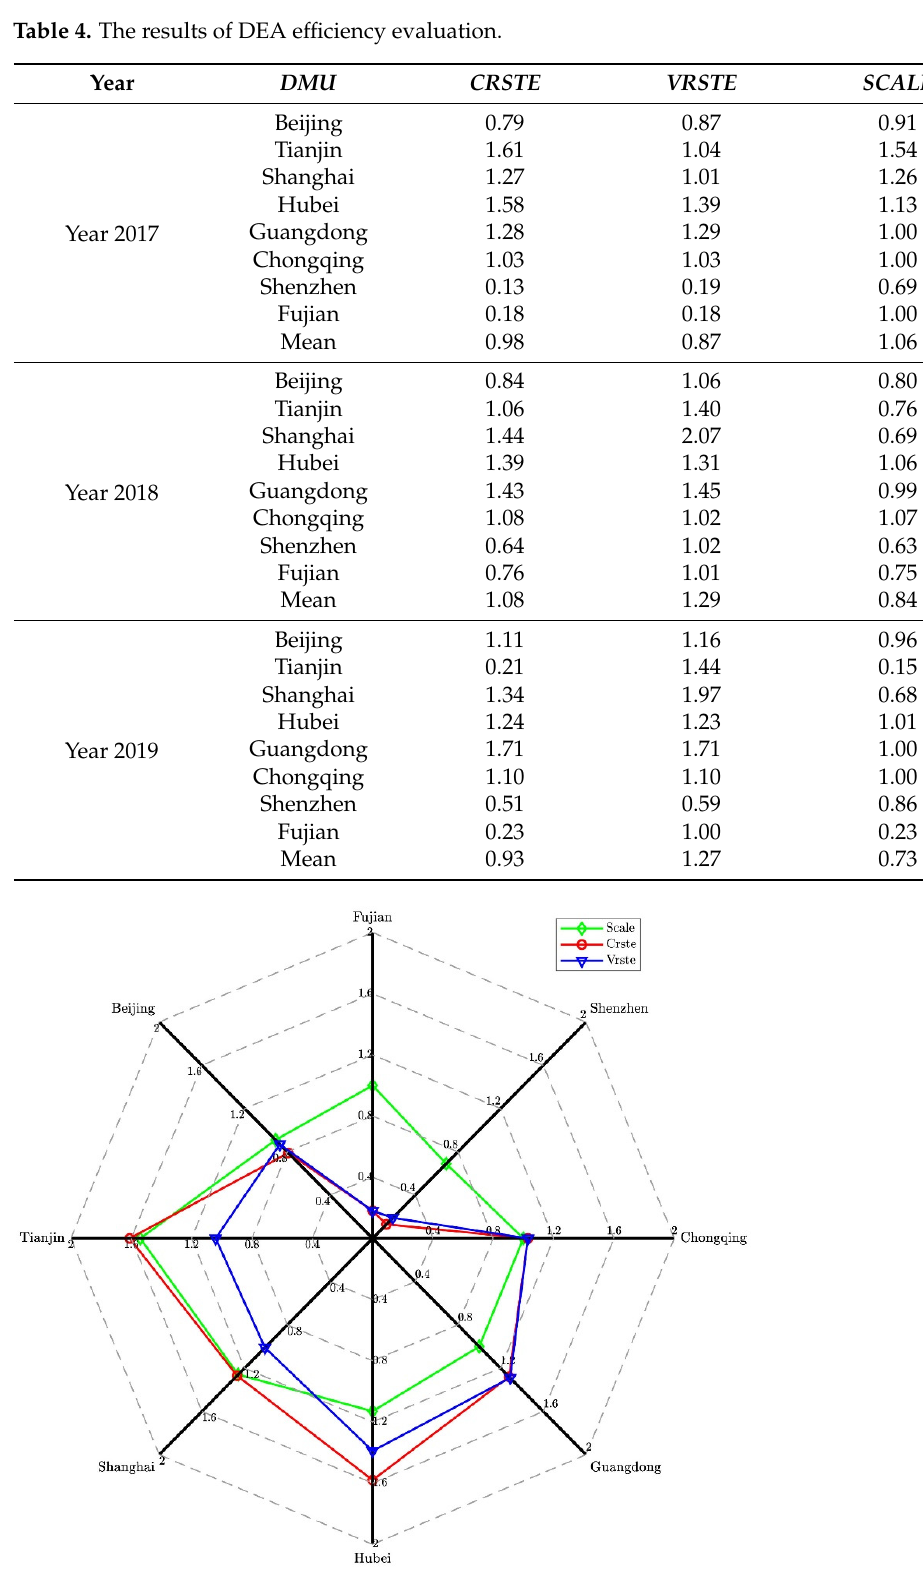
Figure 3. DEA efficiency measurement of the carbon market in 2017.